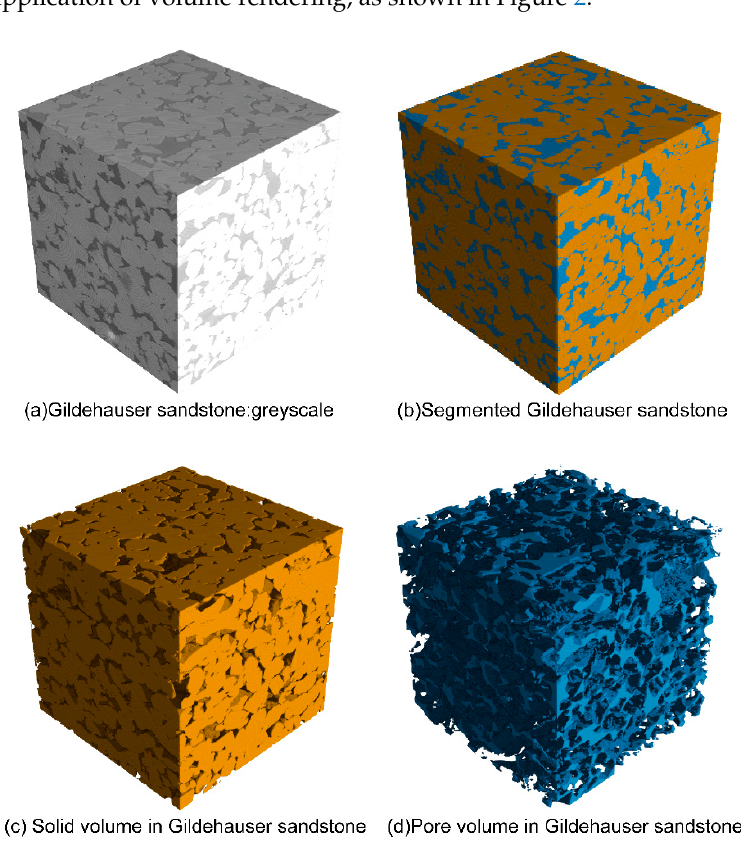
Figure 2. The 3D reconstruction of Gildehauser sandstone sample: ( a ) Gildehauser sandstone: greyscale, ( b ) segmented Gildehauser sandstone, ( c ) solid volume in Gildehauser sandstone, and ( d ) pore volume in Gildehauser sandstone.